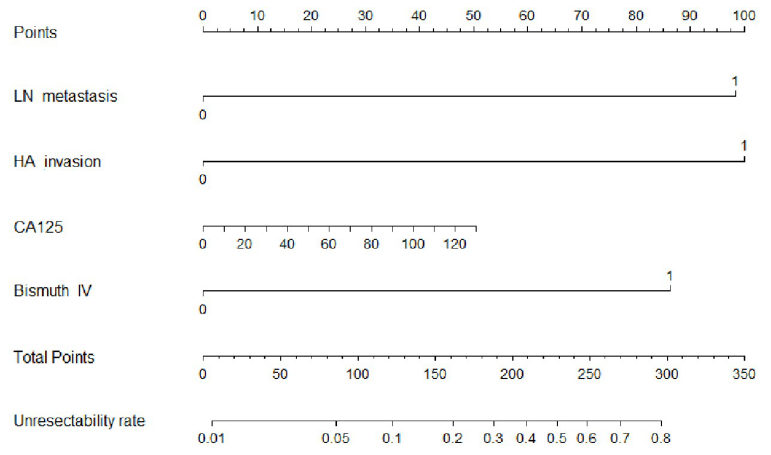
Fig 3. Nomogram predicting intraoperative unresectability of HCCA in training cohort.